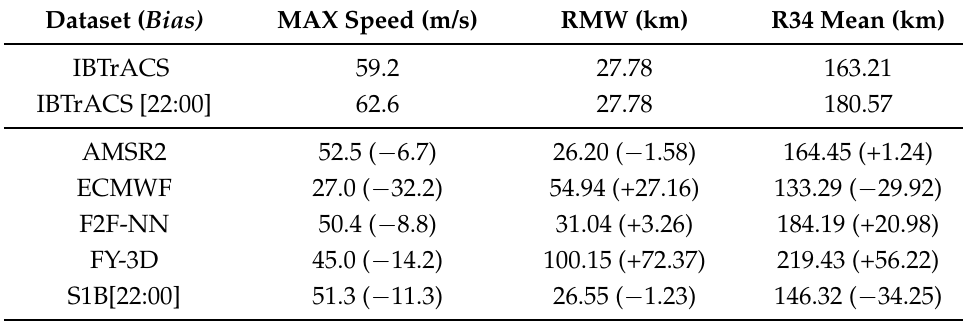
Table 5. Description results of Hurricane Sam by various wind